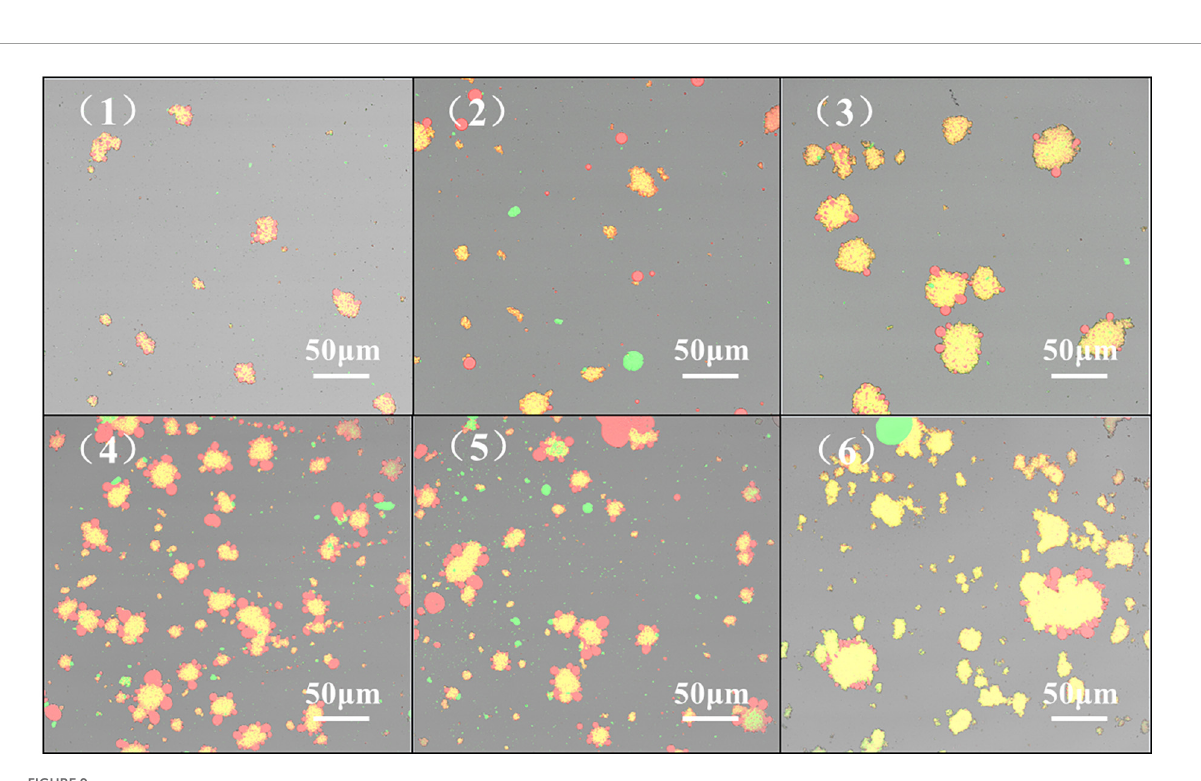
FIGURE9 Effect of high-pressure homogenization (HPH) on confocal laser microscope scanning images of enzymatic hydrolyzed soybean protein concentrate (SPC). Note: (1-6) in the figure represent HPH treatment of 0, 20, 40, 60, 80, and 100 Mpa after enzymatic